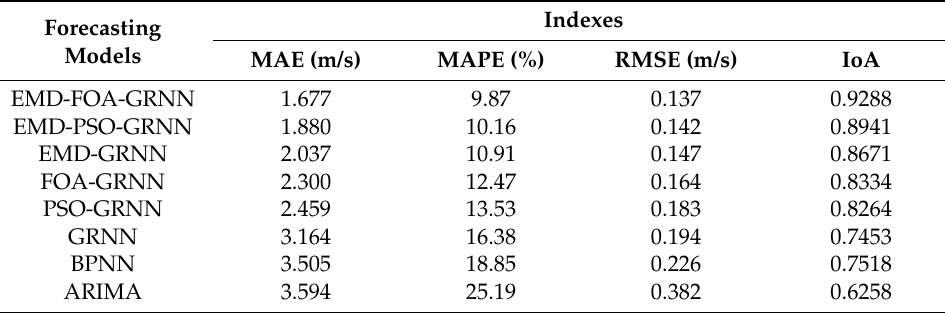
Table 6. Statistical error measures of prediction methods in Case Two.